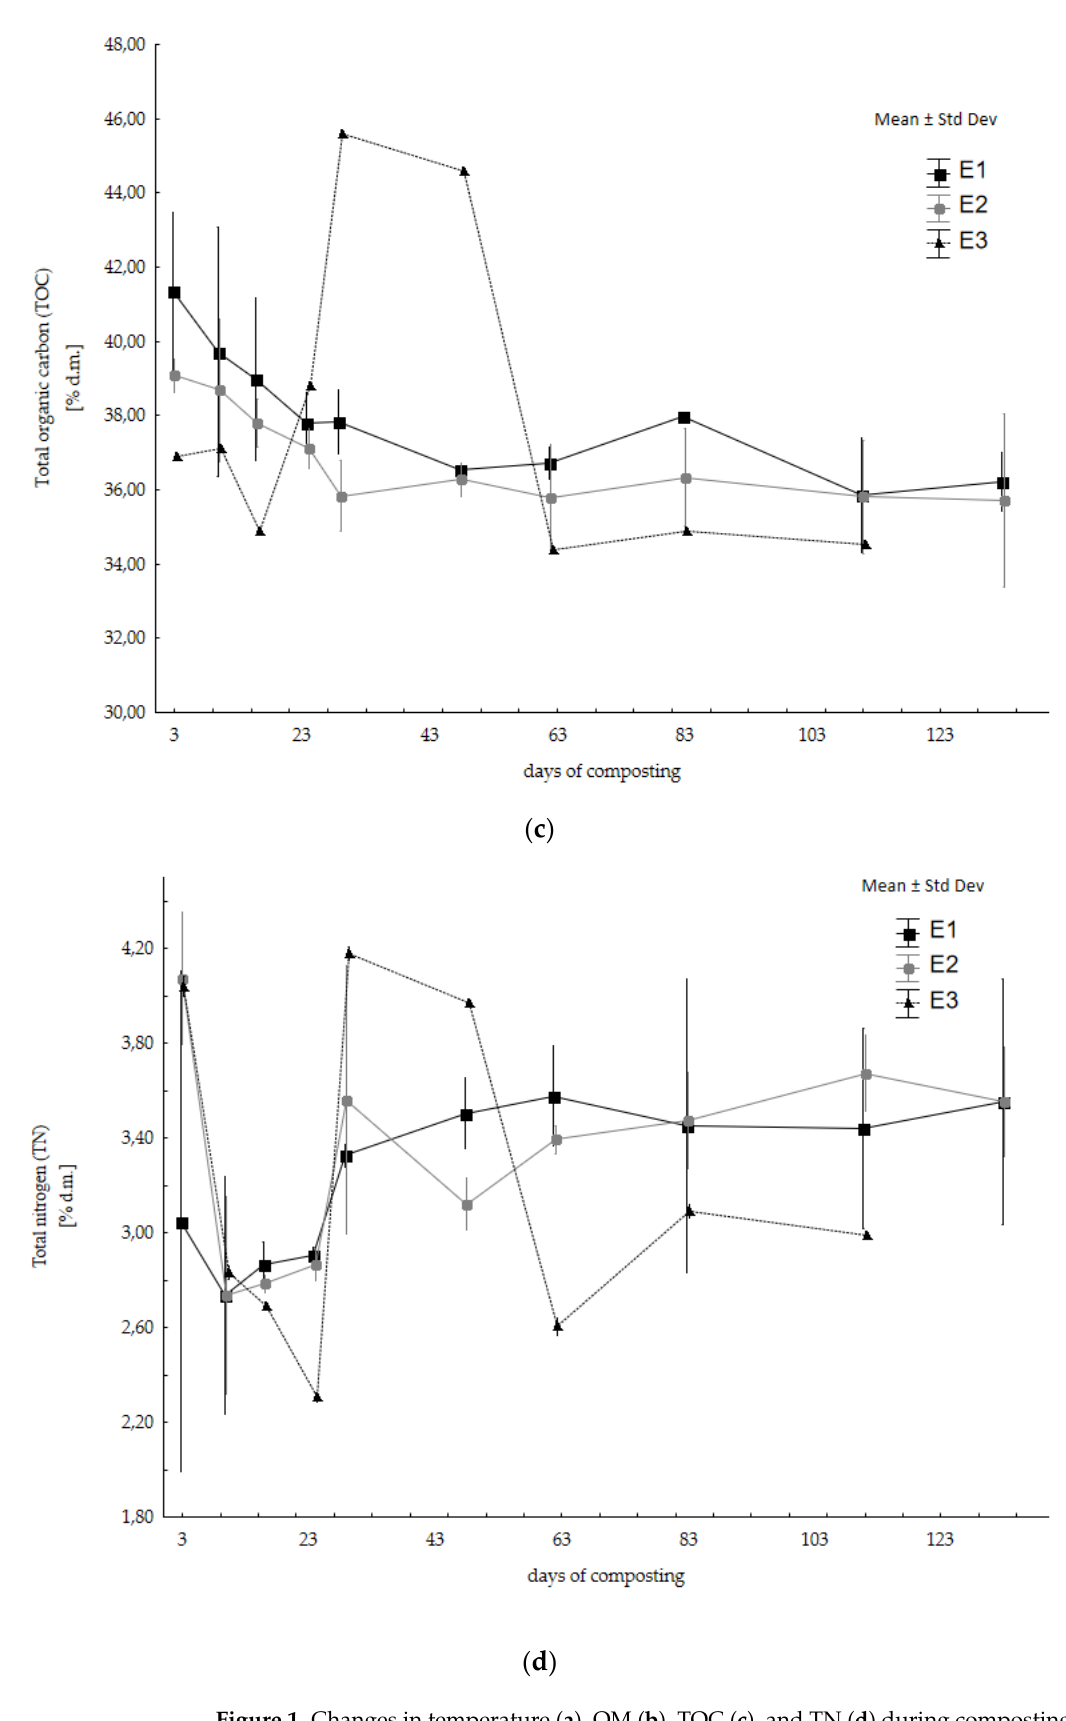
Figure 1. Changes in temperature ( a ), OM ( b ), TOC ( c ), and TN ( d ) during composting.